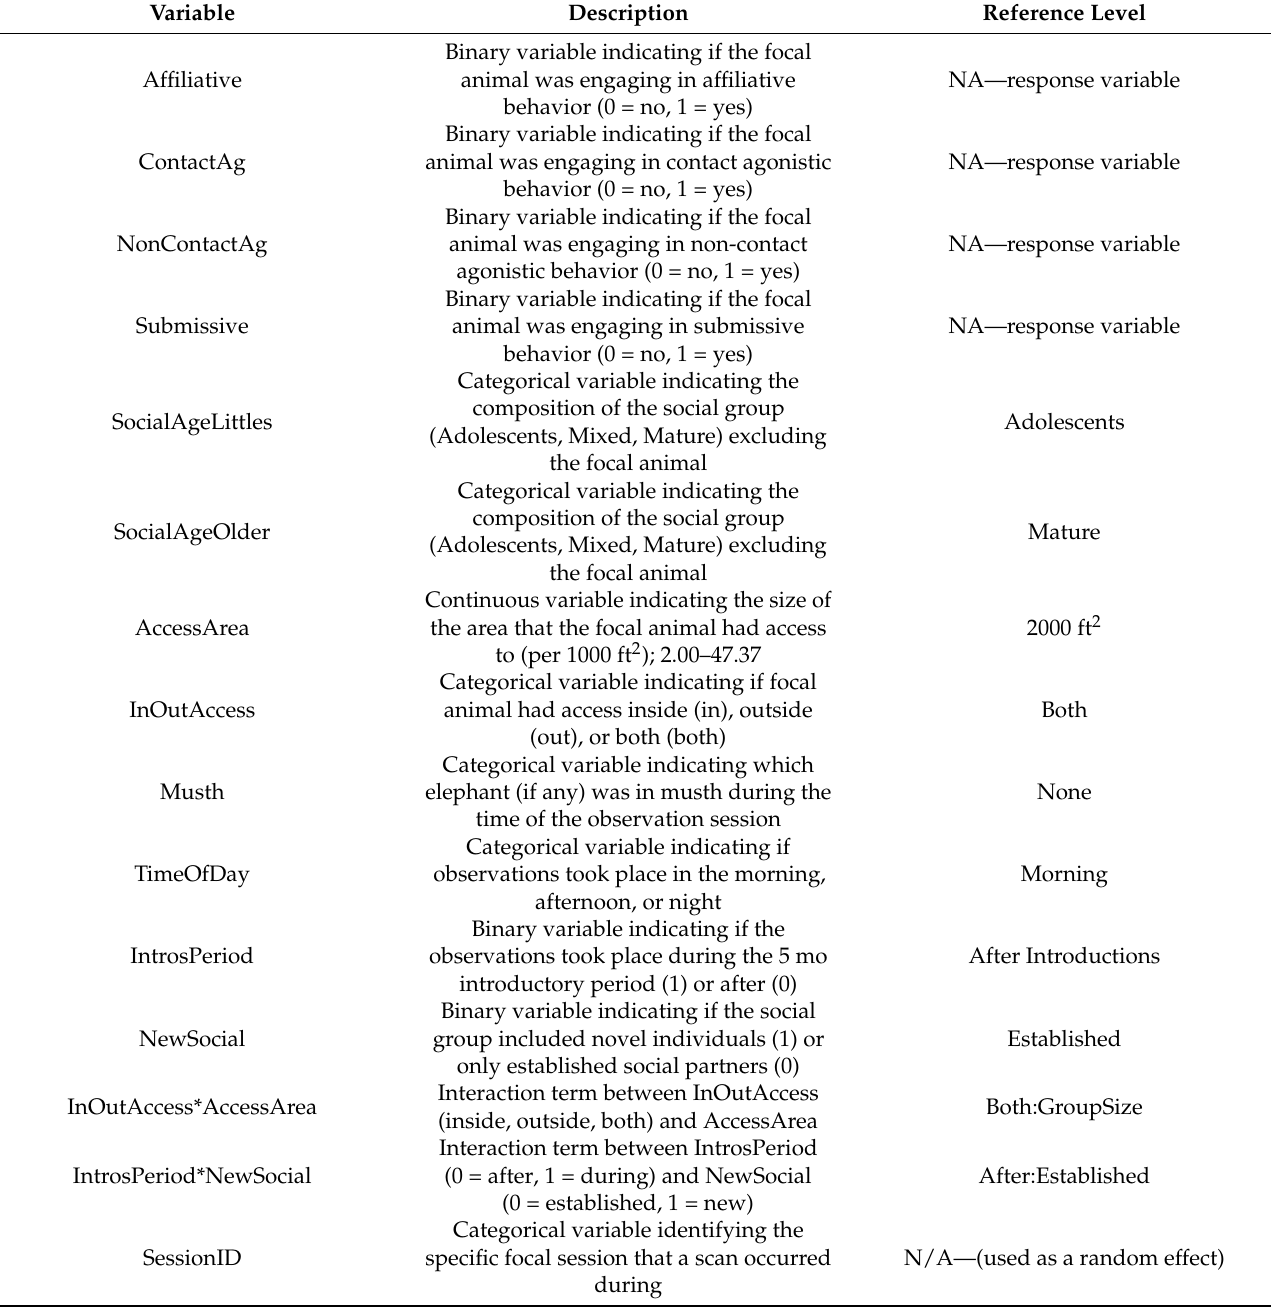
Table 2. Description of variables and interactions considered in our Generalized Estimating Equation Models